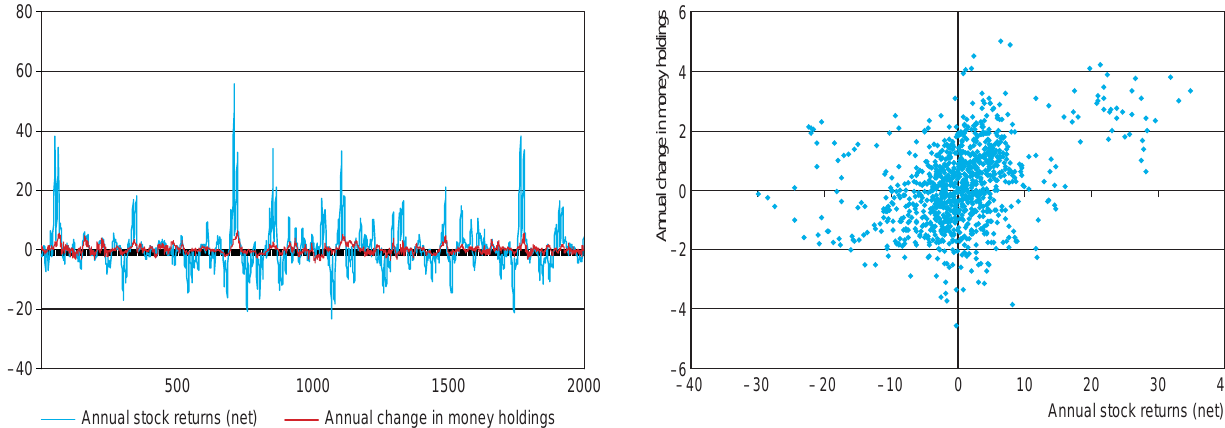
Fig. 3. Typical relationship between stock returns and liquidity in a constant dividend